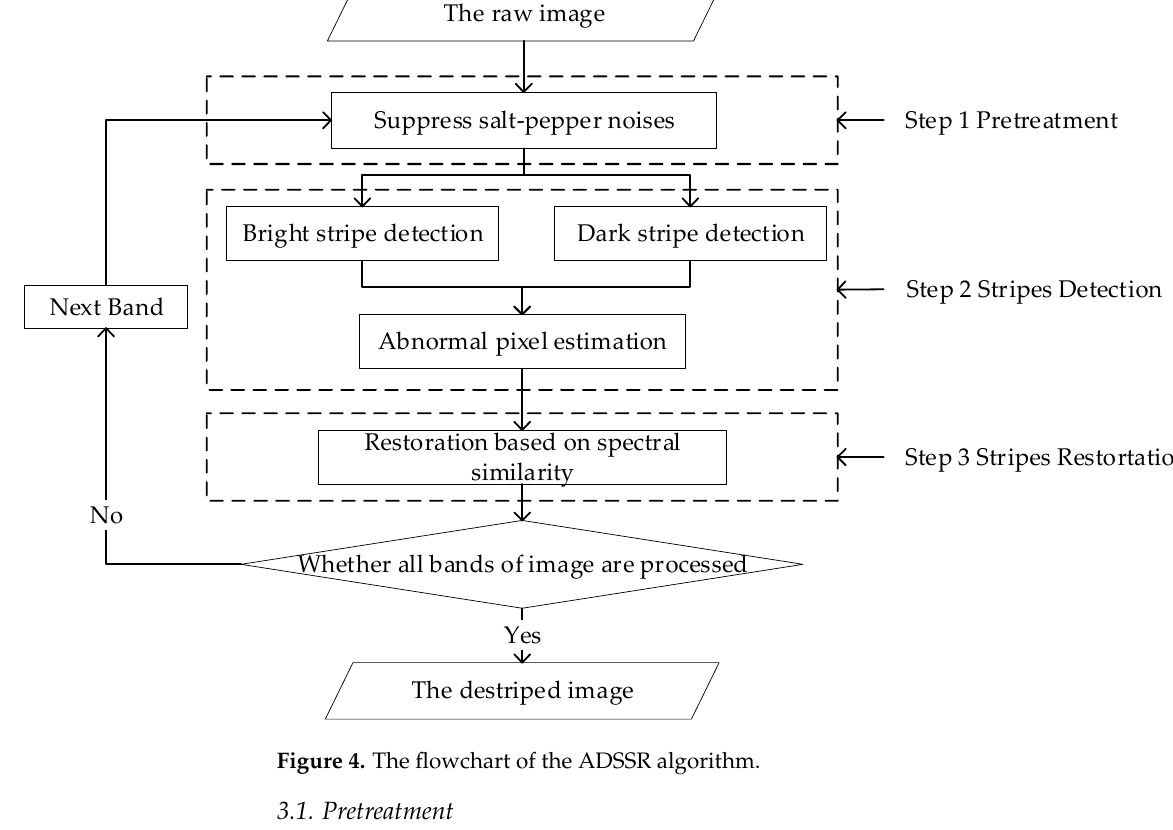
Algorithm 1. Salt-pepper noise suppression